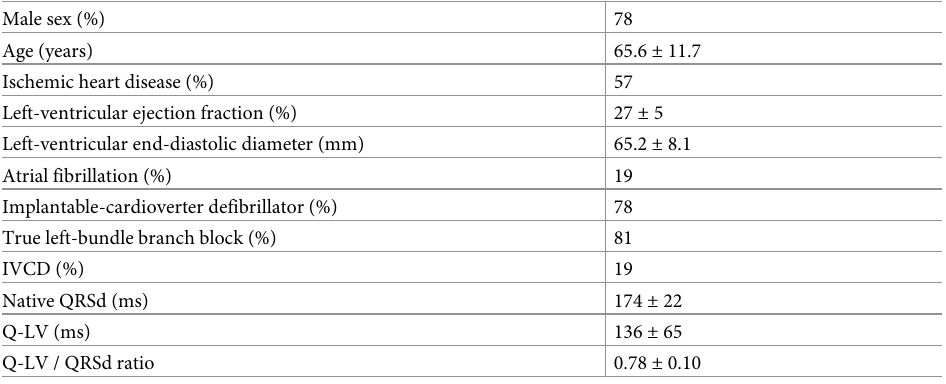
Table 1. Demographic characteristics of the study population (N =